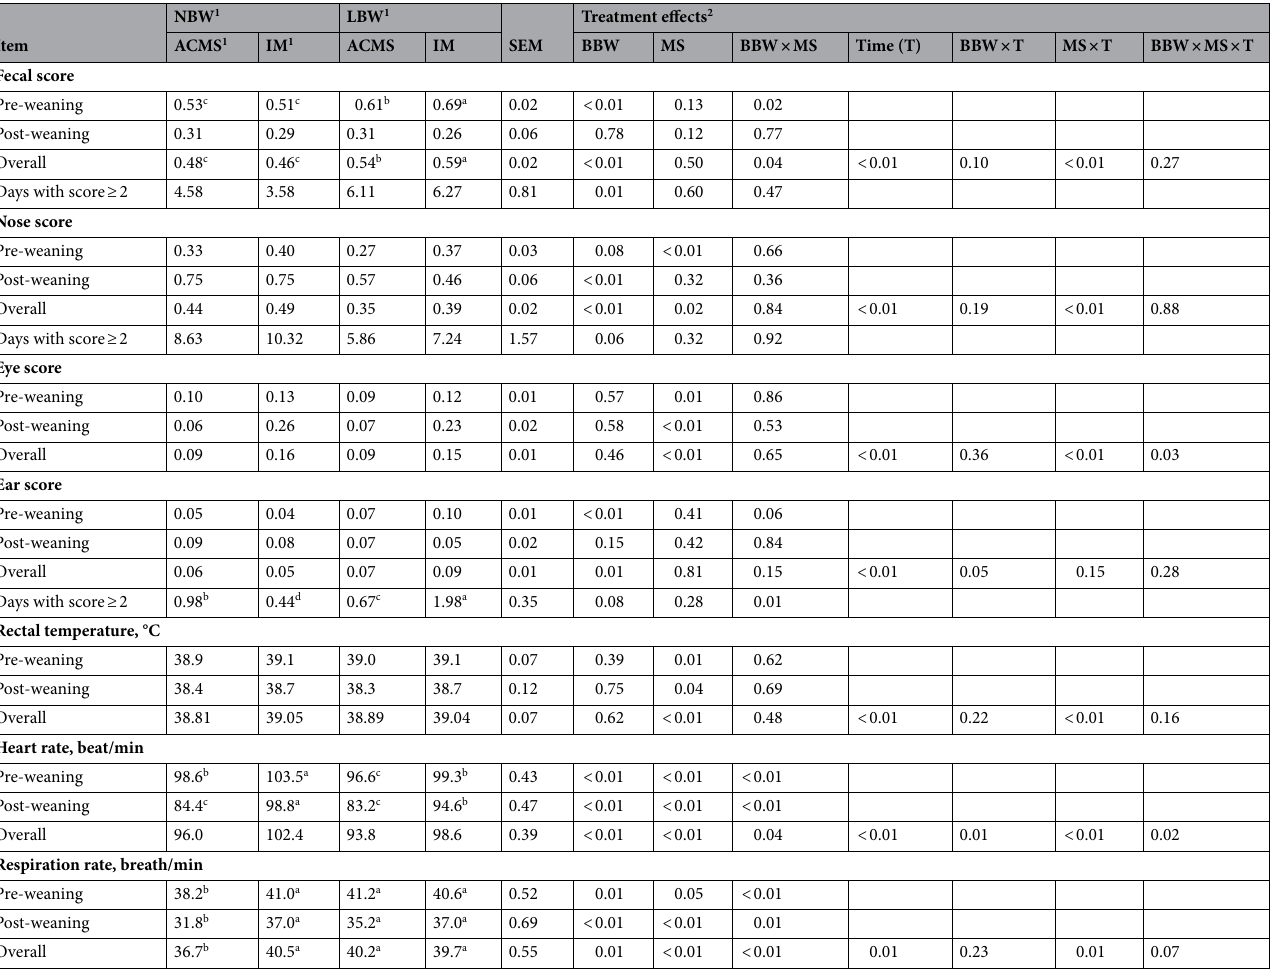
Table 6. Effects of dietary mineral source and birth body weight (BBW) on health scores of dairy calves (n = 13 per treatment). 1 IM inorganic minerals source, ACMS advanced chelated mineral source, LBW